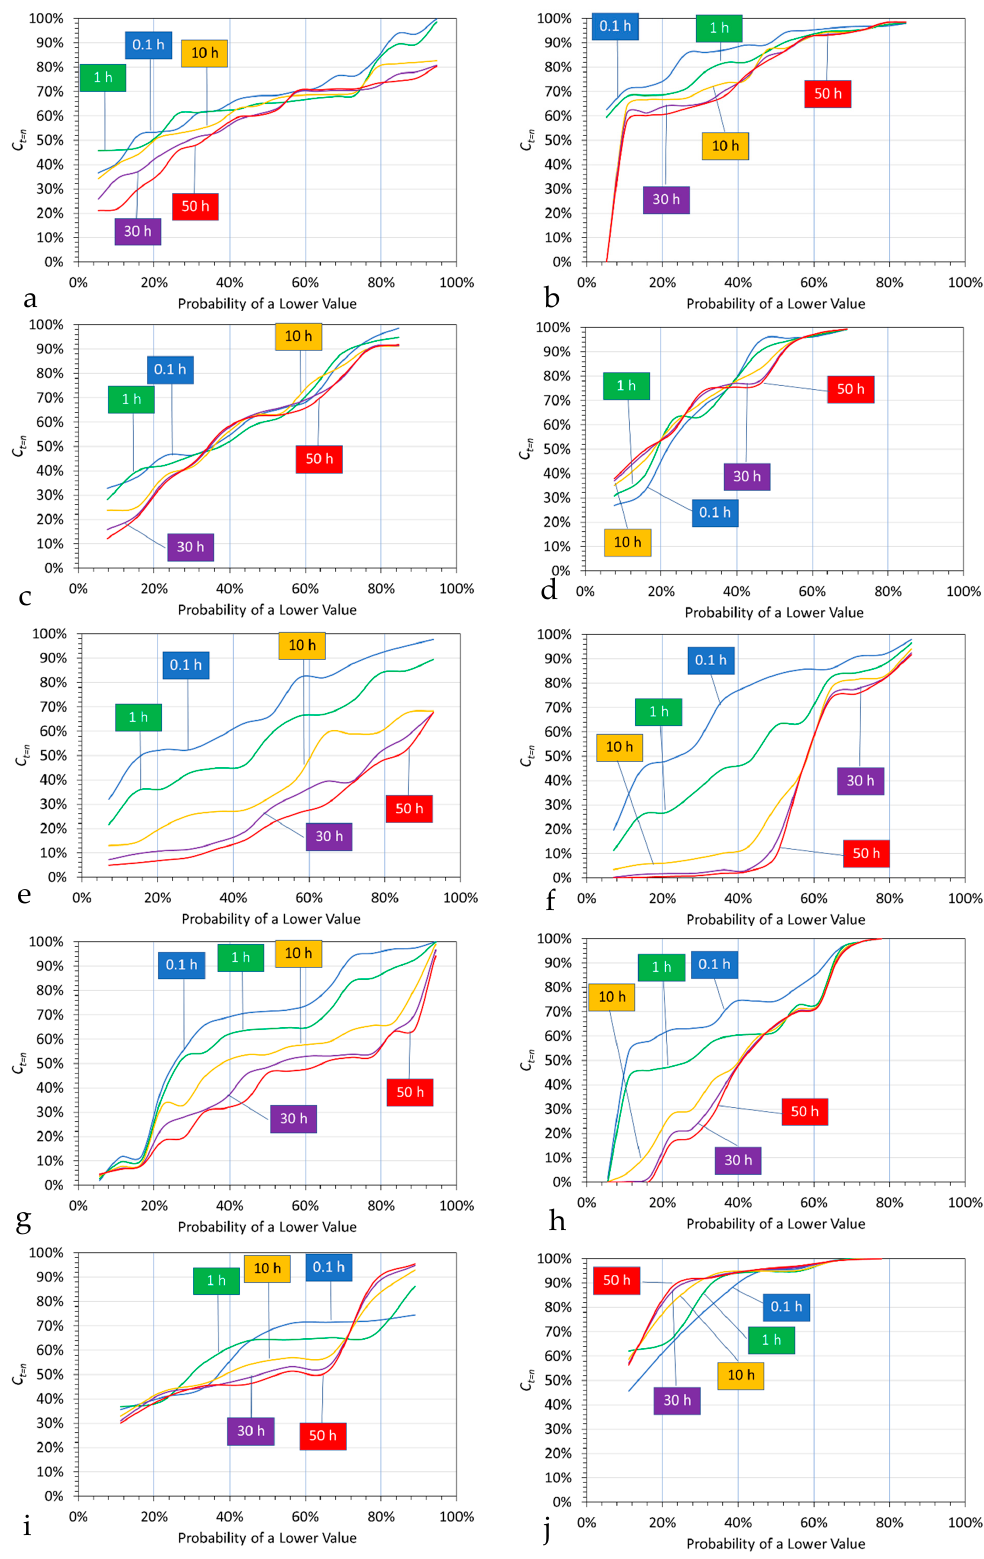
Figure 11. Probability of a lower value versus proportion of an ion removed; h = hours. ( a ), Mg@Al polymer: chloride; ( b ), Mg@Al polymer: sodium; ( c ), Fe@Mg@Al polymer: chloride; ( d ), Fe@Mg@Al polymer: sodium; ( e ), Fe@Ca@Zn polymer: chloride; ( f ), Fe@Ca@Zn polymer: sodium; ( g ), Fe@Ca polymer: chloride; ( h ), Fe@Ca polymer: sodium; ( i ), Ca polymer: chloride; ( j ), Ca polymer: